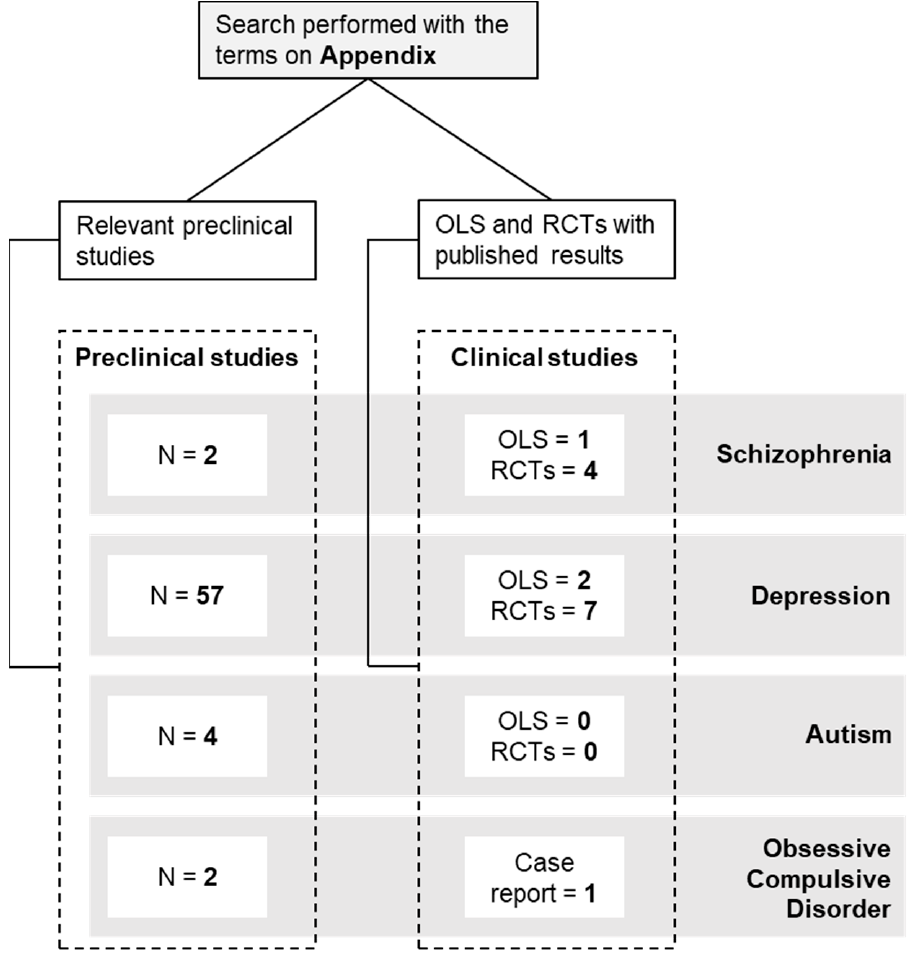
Figure 2. Selected preclinical studies, open-label studies and clinical trials.